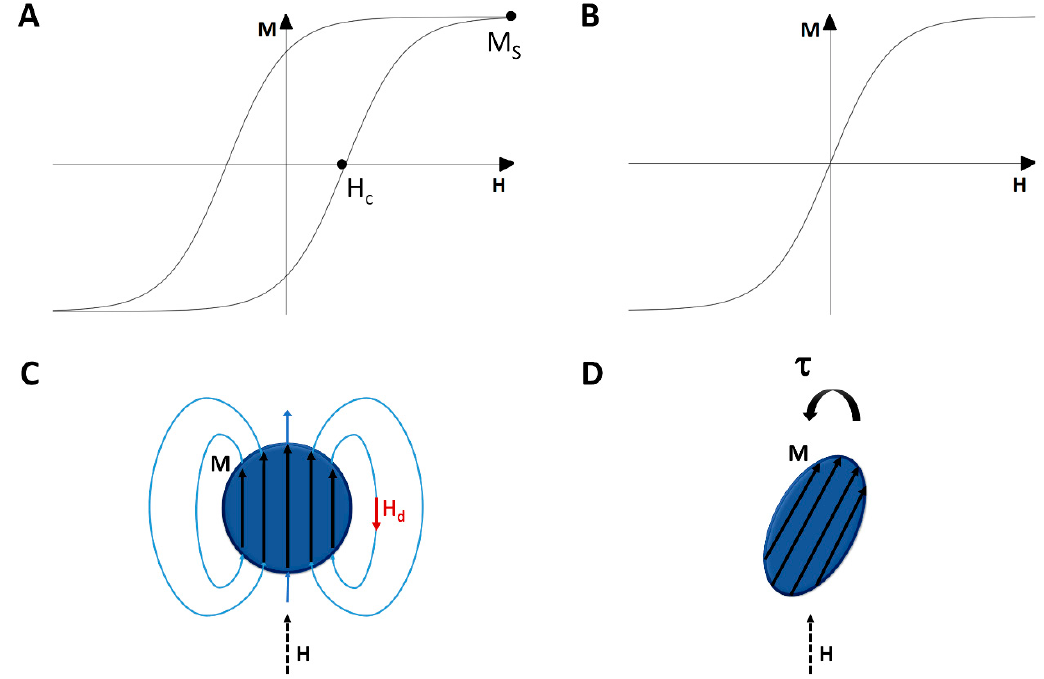
Figure 2. Schematic M-H curves of ( A ) A ferromagnet and ( B ) A superparamagnet; ( C ) A schematic showing the demagnetization field in a spherical magnetic particle; ( D ) A schematic showing a non-spherical magnetic particle can experience a magnetic torque even in a uniform field.